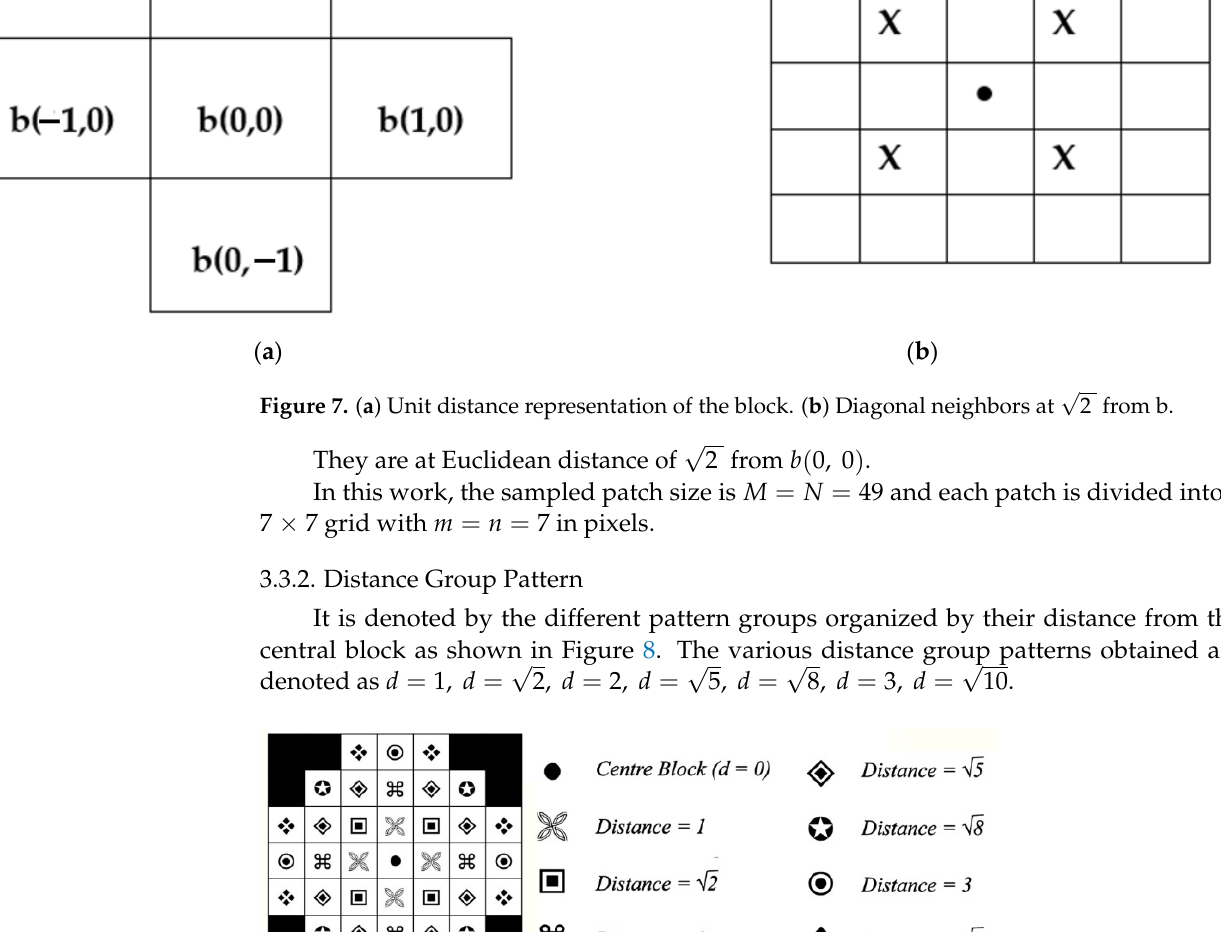
Figure 8. Distance Group Pattern.